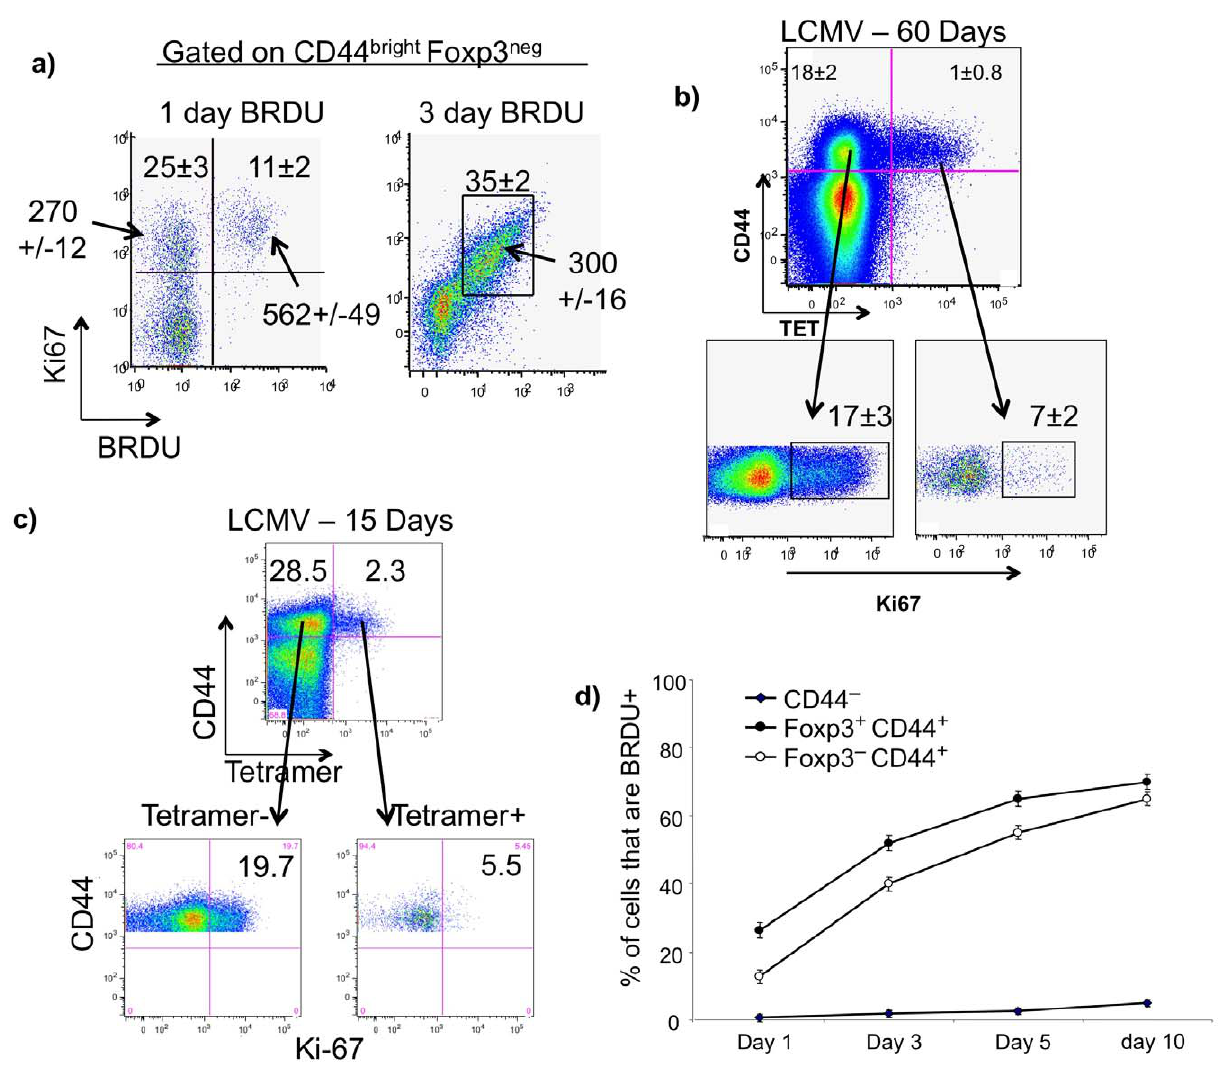
Figure 1. Rapid proliferation of MP cells. (A) Mice received a single IP injection of BrdU (1 mg) and were humanely killed 24 h later or received BrdU for 3 d in their drinking water (0.8 mg/ml) and were humanely killed at the end of the labeling period. Lymph node cells were collected and stained with anti-Foxp3, anti-CD4, anti-CD44, anti-Ki-67, and anti-BrdU. Numbers inside the quadrants are the mean frequencies of BrdU + /Ki-67 + and BrdU 2 /Ki-67 + cells (mean 6 standard deviation [SD] for three replicate animals). Numbers with arrows are the MFI of Ki-67 staining (mean 6 SD). (B) B6 mice were infected IP with 2 6 10 5 plaque-forming unit (PFU) of LCMV Armstrong; 60 d later, spleen cells were stained with an I-A b -GP66-77 (DIYKGVYQFKSV) tetramer, anti-CD44, anti-CD4, and anti-Ki-67. In the upper panel, the mean frequency of CD44 bright cells among the tetramer + and tetramer 2 cells from three replicates is shown (mean 6 SD). The proportion of Ki-67 + cells among the CD44 bright tetramer 2 and tetramer + cells is shown in the lower panel. (C) B6 mice infected with LCMV Armstrong 15 d earlier were analyzed for CD44 expression and tetramer binding. The lower panels represent the proportion of Ki-67 + cells among CD44 bright tetramer + and tetramer 2 cells. (D) Normal B6 mice were placed on BrdU (0.8 mg/ml) in their drinking water for a period of 10 d. On days 1, 3, 5, and 10, mice were humanely killed and lymph nodes cells were collected and stained with anti-Foxp3, anti-CD4, anti-CD44, and anti-BrdU.